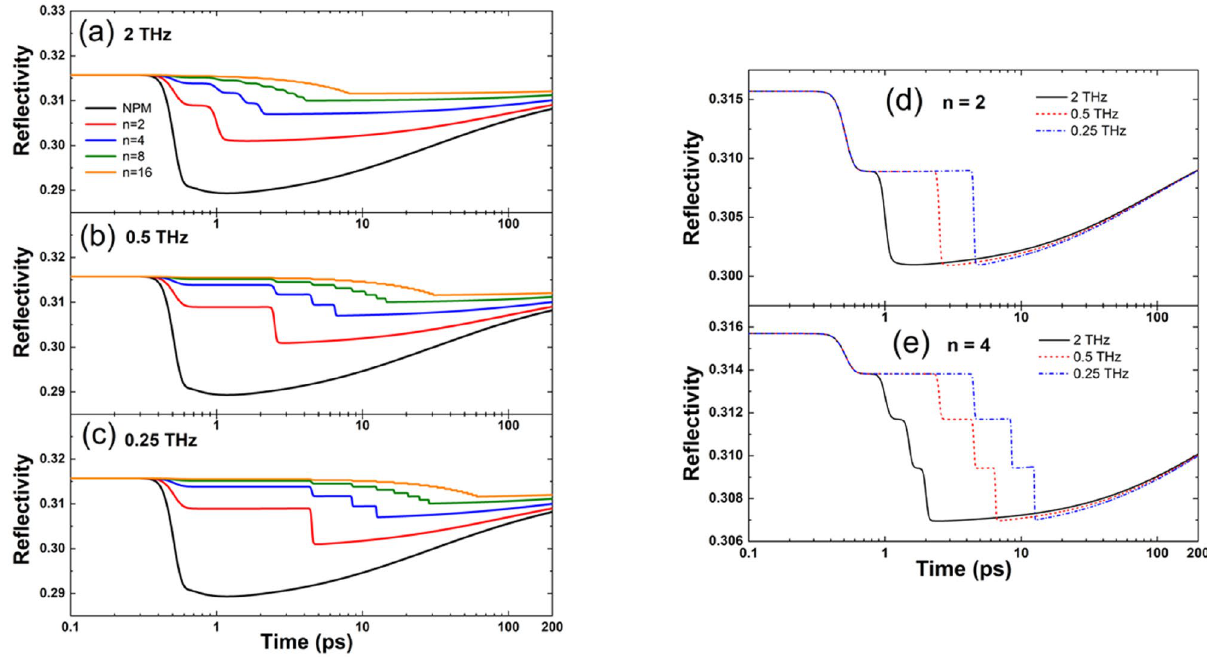
Figure 2. Reflectivity at the surface z = 0 nm as a function of time for intra-burst frequencies ( a ) 2THz, ( b ) 0.5 THz, ( c ) 0.25 THz. Comparison of reflectivity at the surface z = 0 nm as a function of time for different intra- burst repetition rates with ( d ) n = 2 and ( e ) n = 4